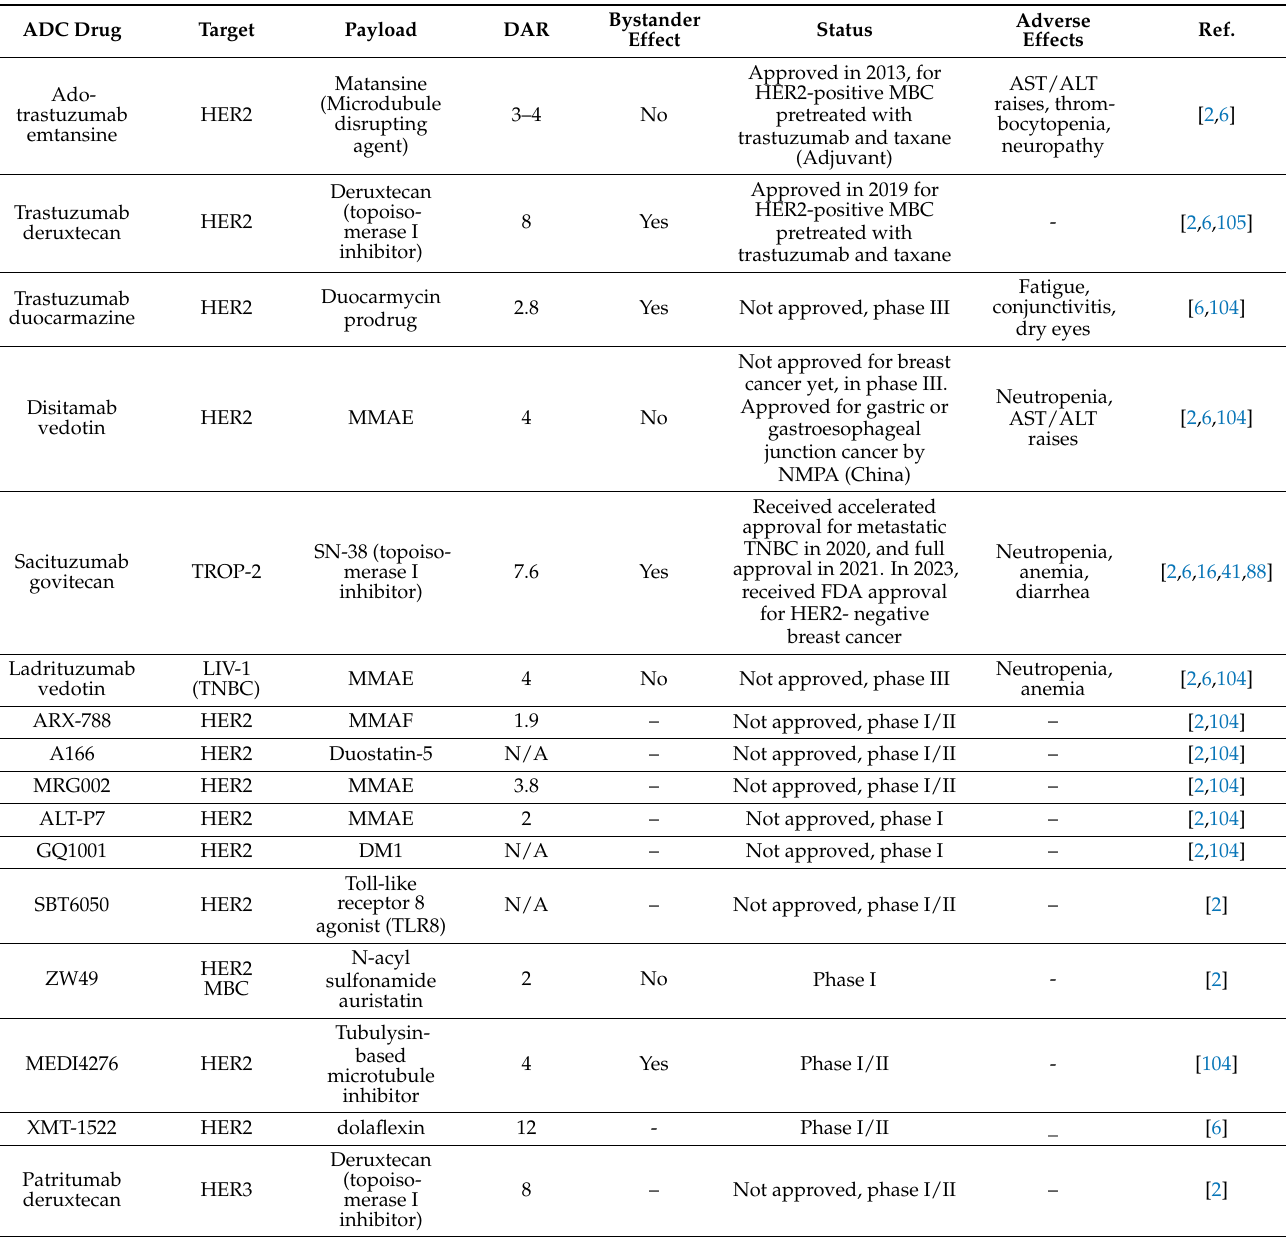
Table 3. ADC drugs for breast cancer therapy either approved or in various phases of clinical